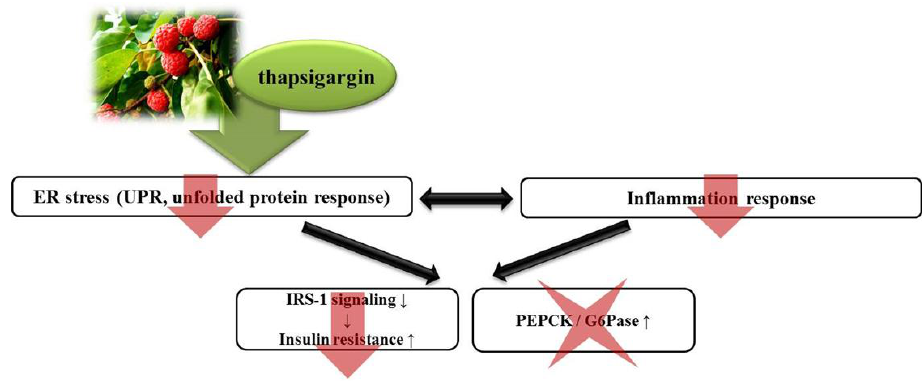
Figure 6. Effect of CTL on ER stress-induced inflammation and hepatic insulin resistance. The present study indicates that CTL can improve hepatic insulin resistance via suppression of ER stress-induced inhibition of IRS signaling and the inflammation response, but that they do not interrupt the C/EBPα/gluconeogenic gene pathway. the C/EBP α /gluconeogenic gene